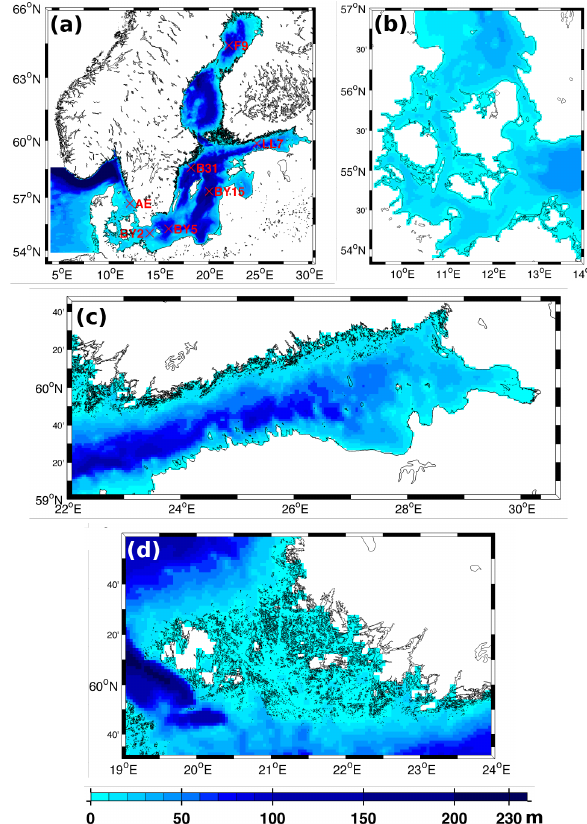
Figure 1. Horizontal model grid and bathymetry. Panel (a) shows the entire model domain, with red crosses indicating internationally renowned monitoring stations. Panel (b) , (c) and (d) are close-ups of the Danish Straits, the Gulf of Finland, and the region between Åland and Finland, respectively. The coloured bins denote the water depth of each model water column. The white areas are considered as land by the model. The actual coastline is denoted by a black line.